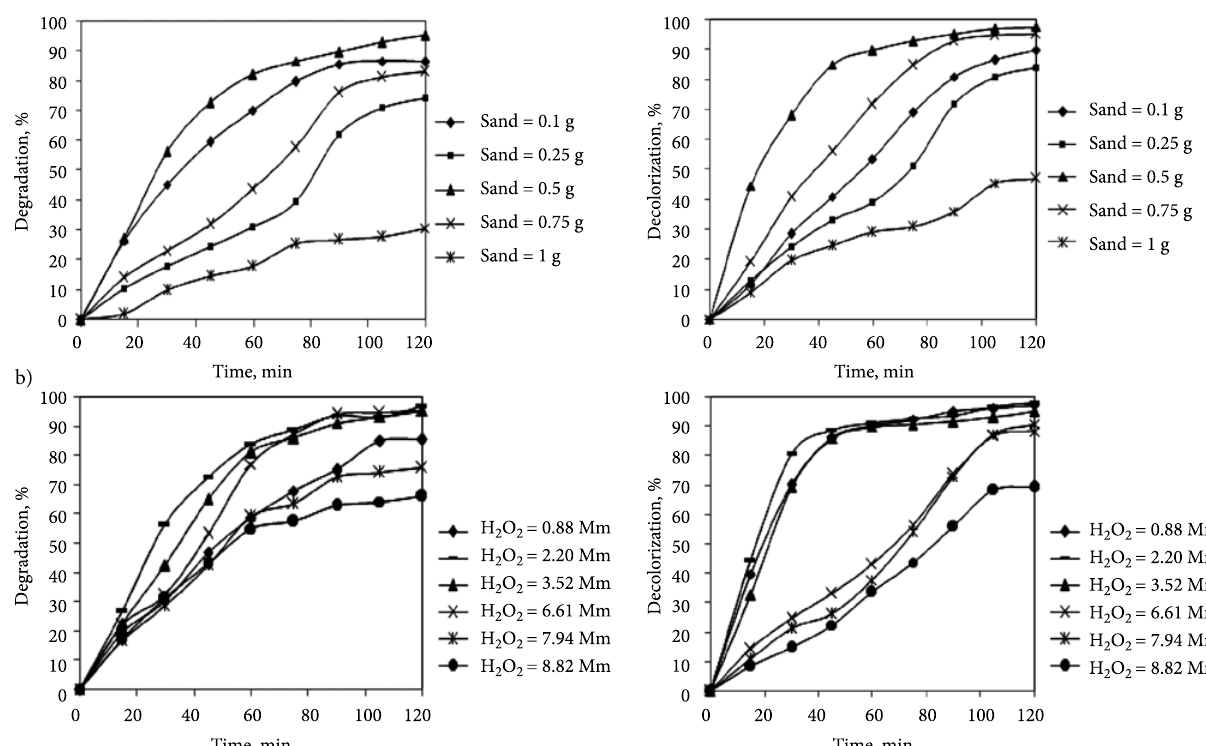
Fig. 5. Percentage degradation and decolourization of RB5 at a) varying concentration of FS b) varying concentration of H